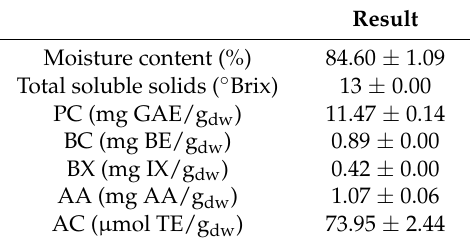
Table 1. Characterization of fresh whole purple cactus pear